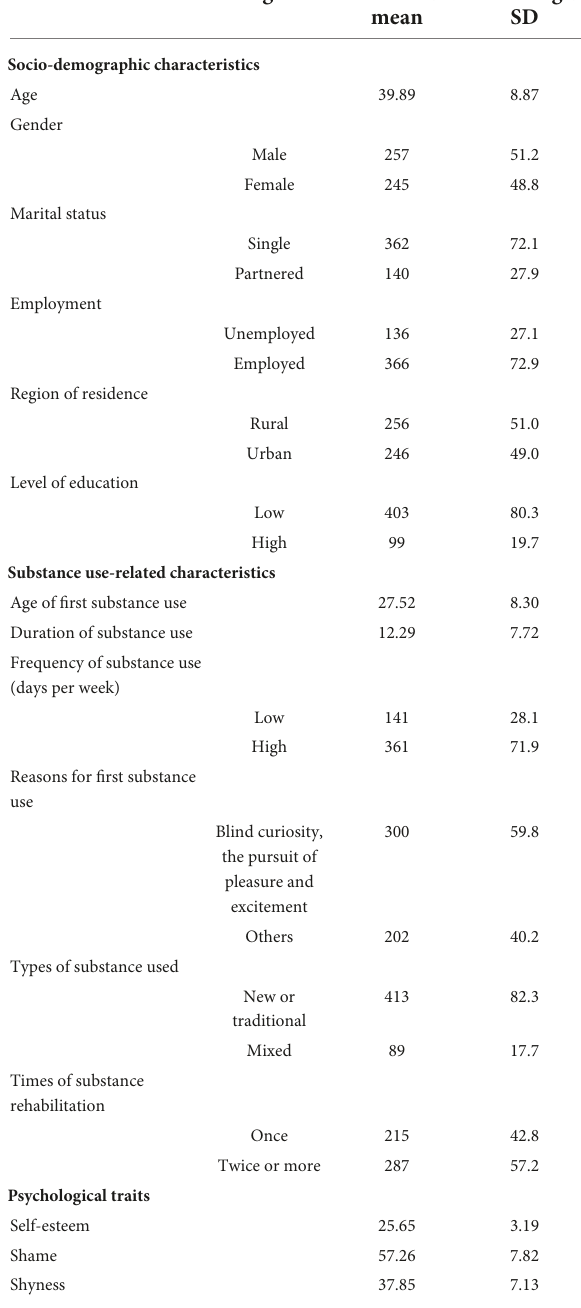
TABLE 1 Socio-demographic characteristics, substance use-related characteristics, and psychological traits of the substance users.